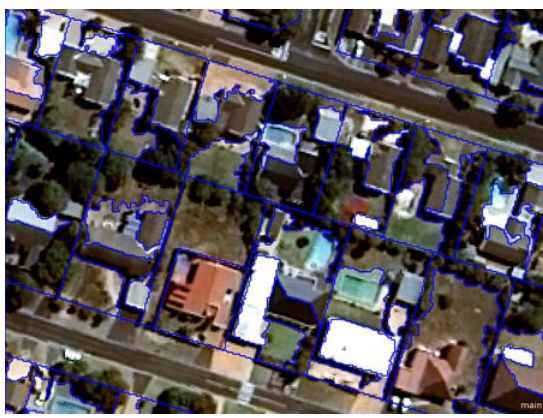
Figure 8: Segmentation within cadastral parcels